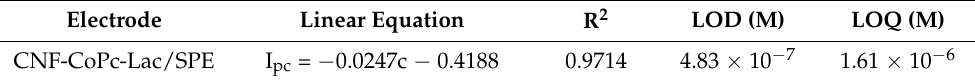
Table 3. Equation of linear dependence between I pc and c, R 2 , LOD, and LOQ for CNF-CoPc-Lac/SPE.